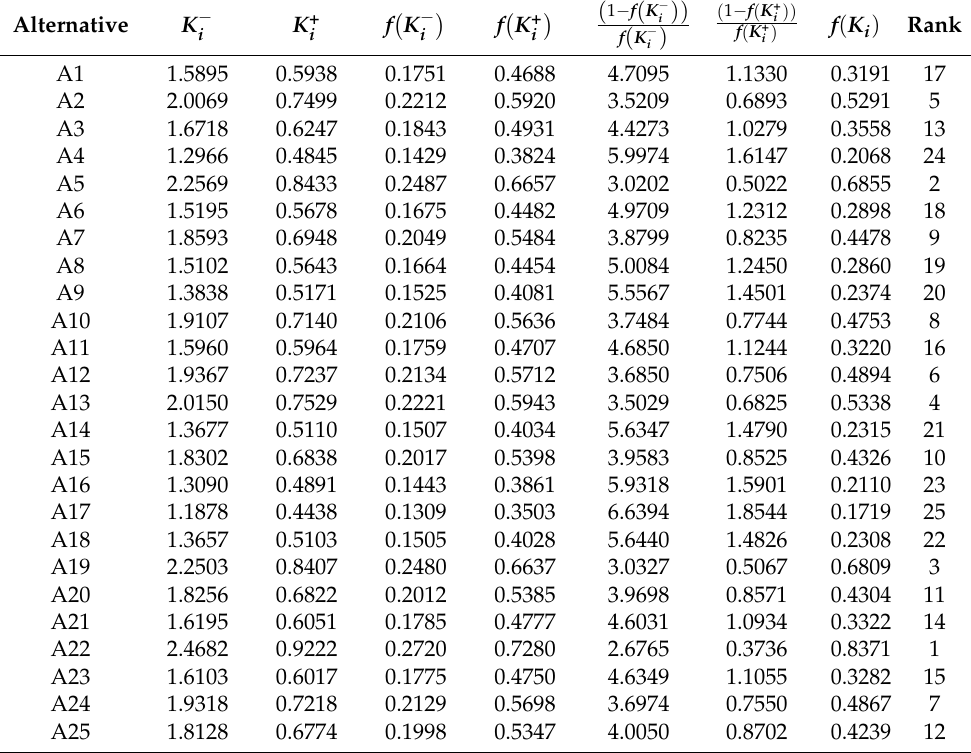
Table 6. Defuzzied utility degree, utility functions, and ranks of the alternatives (case study